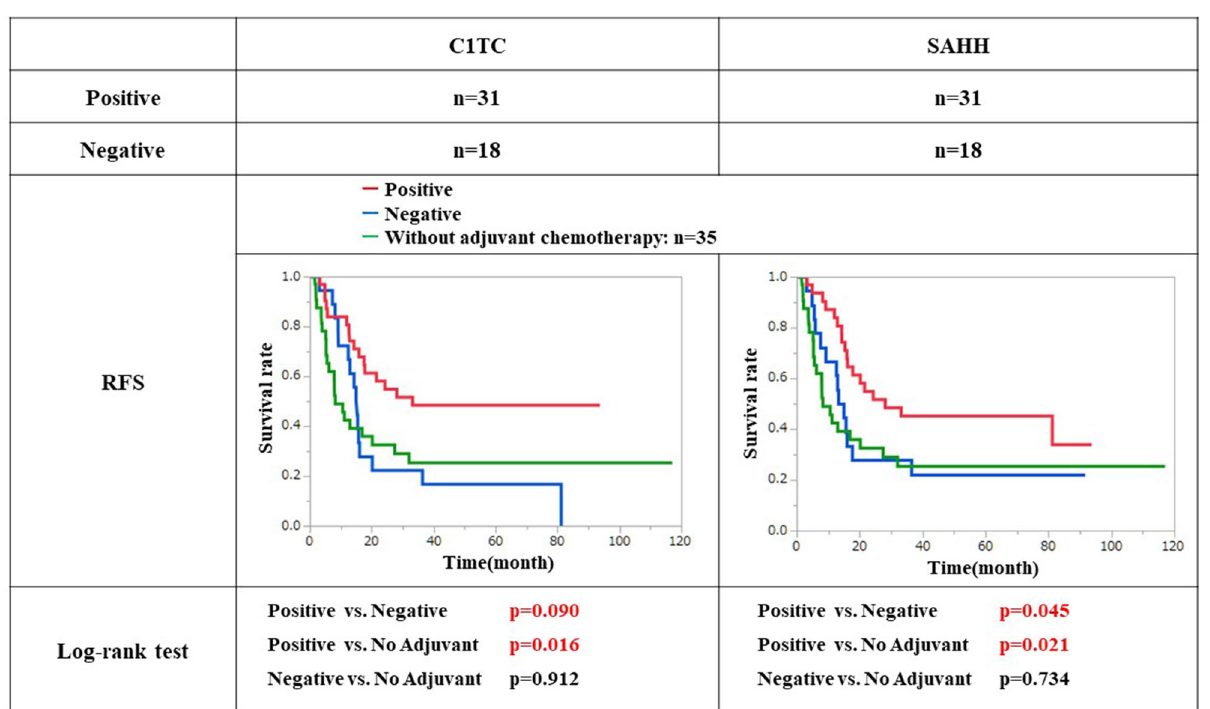
Figure 2. Recurrence free survival of patients with expressing each candidate factors and no adjuvant chemotherapy. In both C1TC and SAHH, a significant improvement of RFS was observed in the positive group compared to the negative group. Furthermore, positive group showed significant improvement of RFS compared with no adjuvant chemotherapy group. On the other hands, no significant difference was fond between negative group and no adjuvant group in both C1TC and